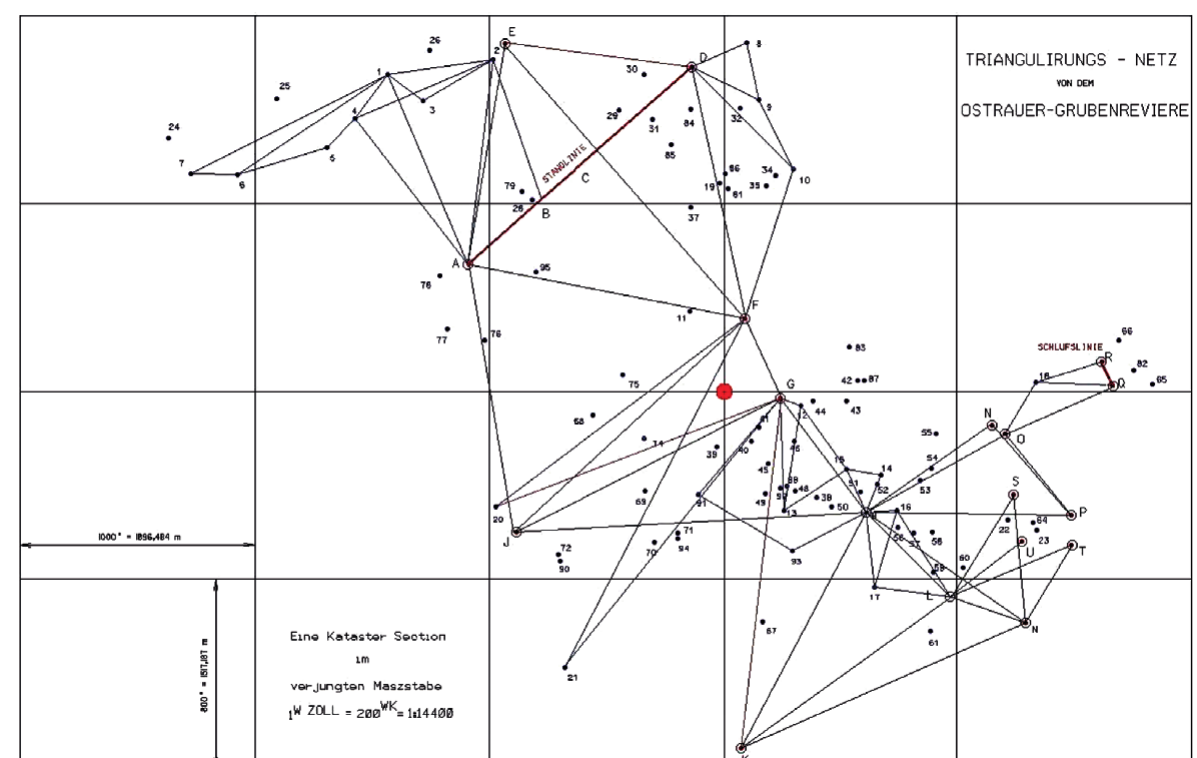
Fig. 3. Overall representation of Ott´s triangulation in the